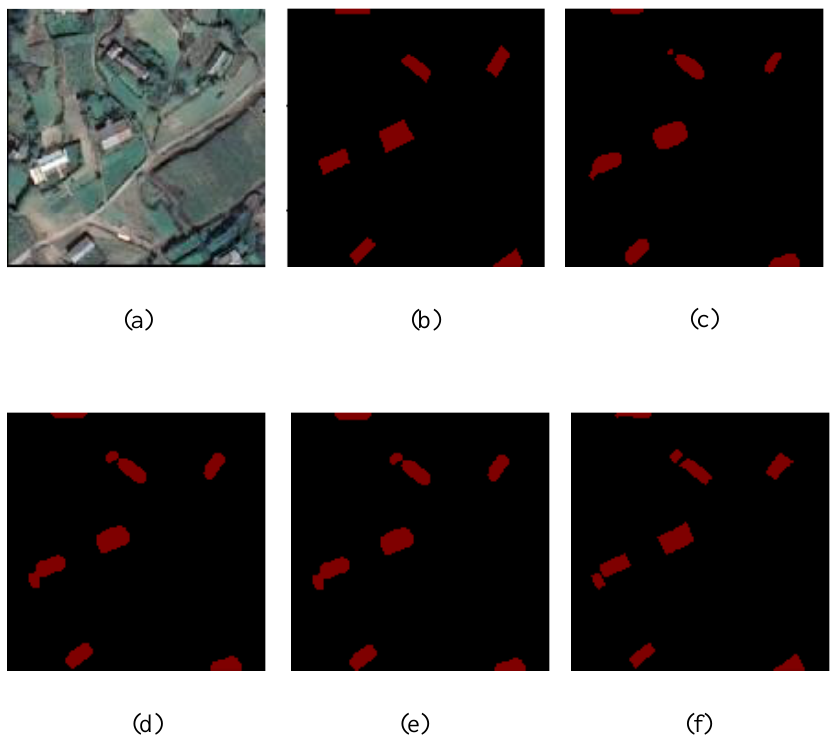
Figure 8. Comparison of reconstruction results using Satellite dataset II (East Asia). ( a ) The input im- age; ( b ) groud truth; ( c ) ResNet50 + ASPP; ( d ) ResNet50 + WASP(AVE); ( e ) LResNet50 + WASP(AVE); ( f ) Our method(LResNet50 + WASP(AVE) + GFG).